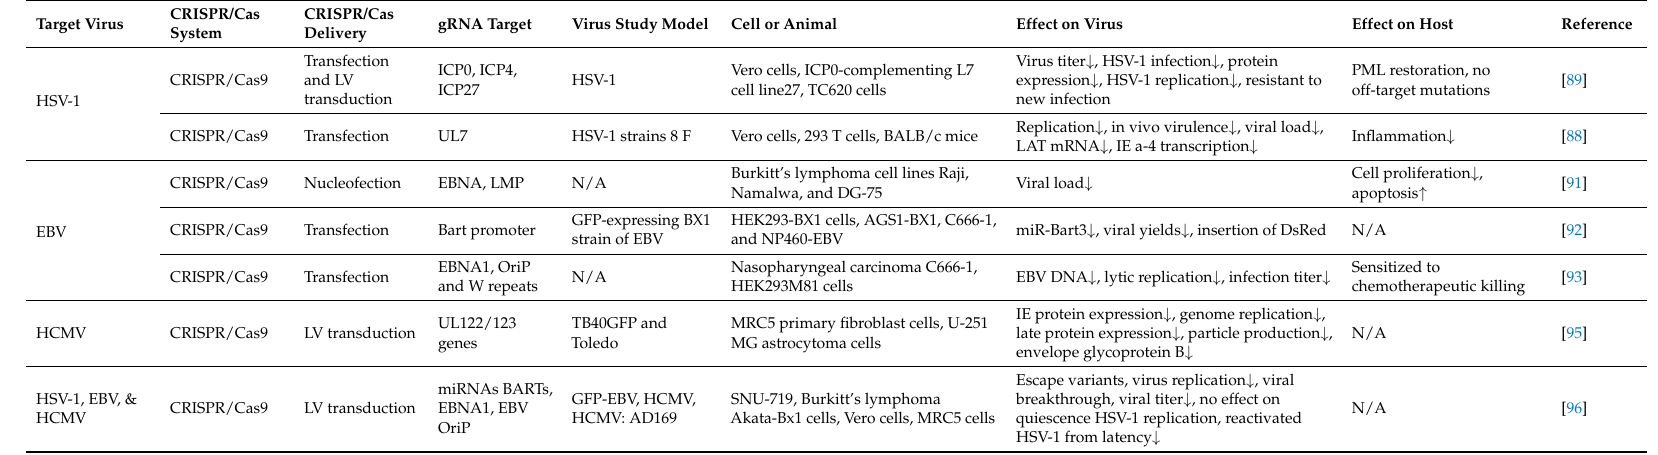
Table 3. Summary of CRISPR/Cas9-based antiviral studies targeting herpes viruses including HSV-1, EBV, and HCMV. Abbreviations used within the table are as follows. HSV-1; herpes simplex virus-1, PML; promonocytic leukemia, LAT; latency-associated transcript, EBV; Epstein Barr virus, EBNA; EBV nuclear antigen, LMP; latent membrane protein, DsRed; red fluorescent protein, HCMV; human cytomegalovirus, IE; immediate early, OriP; origin of